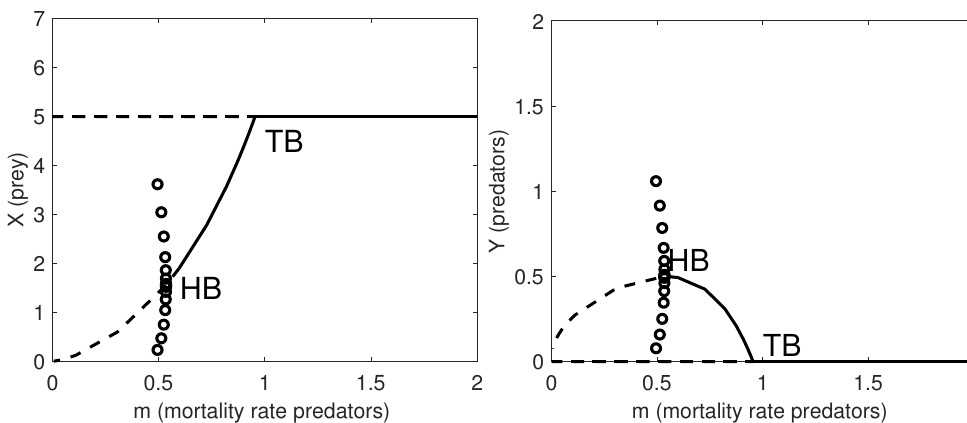
Figure 5. One-parameter bifurcation diagram with respect to the natural mortality rate of the predators, m . Left panel : the prey population dynamics; Right panel : the predator population dynamics. Thick lines: stable equilibria; dashed lines: unstable equilibria. HB: supercritical Hopf bifurcation point where a stable limit cycle arises with maximum amplitude given by the amplitude of the HB (circles); TB: transcritical bifurcation point where the coexistence equilibrium exchanges its stability with the prey-only equilibrium. The remaining parameter values are as in Table 8.